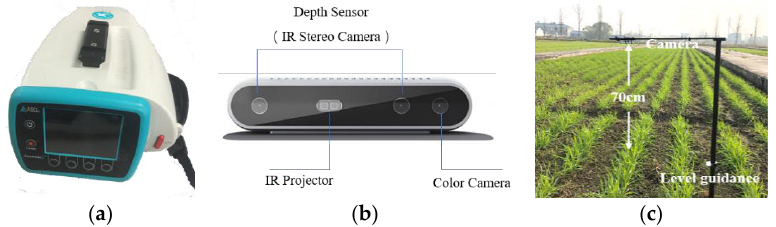
Figure 2. ( a ) ASD FieldSpec HandHeld 2; ( b ) Intel ® RealSense ™ D415 Depth Camera; ( c ) image acquisition